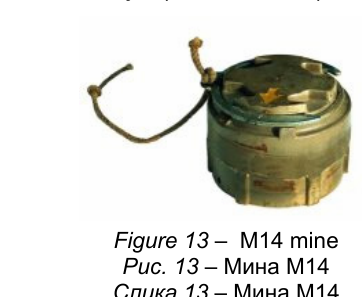
Figure 13 – M14 mine Рис . 13 – Мина М 14 Слика 13 – Мина